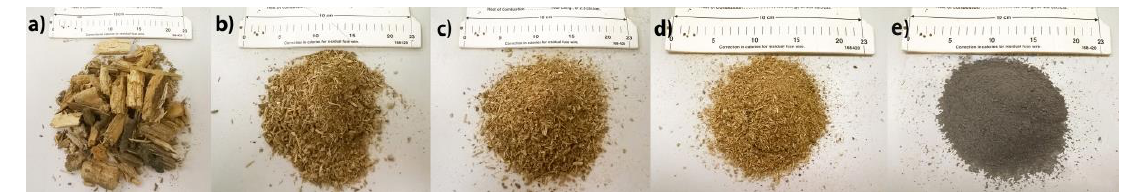
Figure 4. Pictures of the type 1 unbound material ( a ) 20–30 mm; ( b ) 4 mm; ( c ) 2 mm; ( d ) 1 mm; ( e ) lignin flour.